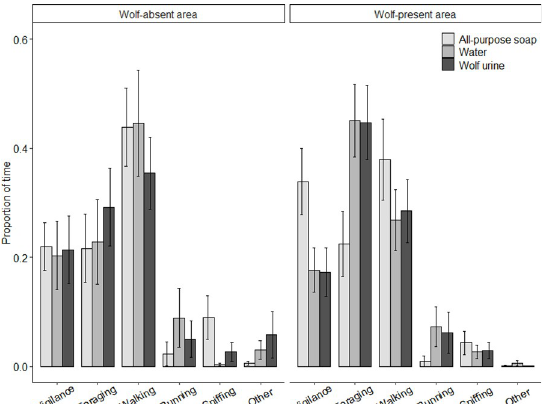
Fig 3. Behavioral response of deer to all-purpose soap, water and wolf urine in both study sites. Average proportion of time red deer in wolf-absent case study (left panel) and the wolf-present case study (right panel) spent on different behavior categories. None of the treatments significantly affected the behavior of red deer living in the wolf- absent area. In the wolf-present area the proportion of time red deer spend on foraging was significantly lower on all- purpose soap plots ( H (2) = 7.088, P = 0.029), whereas the other behavior categories were not affected by our